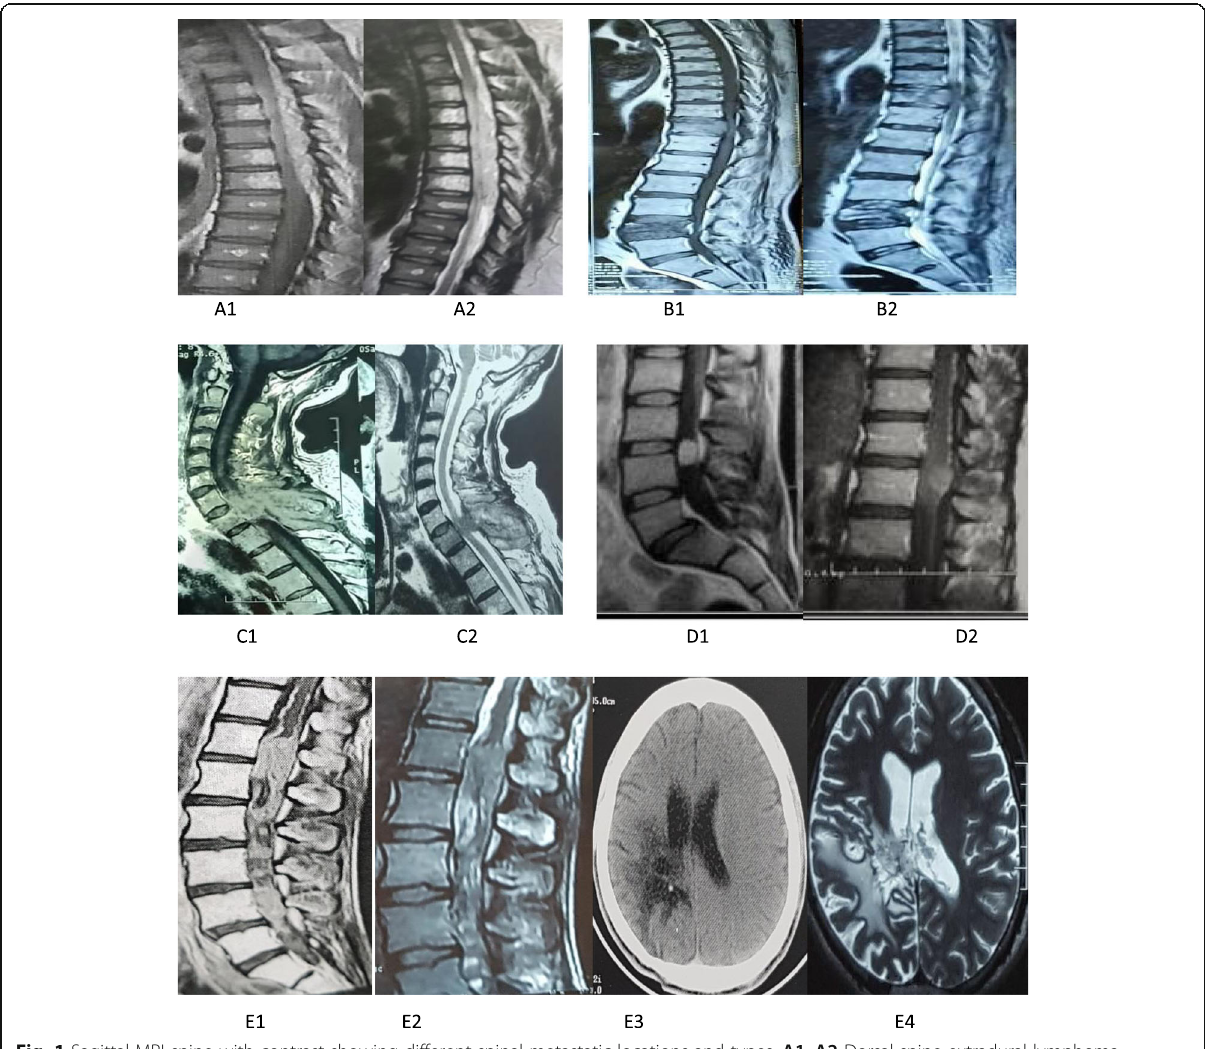
Fig. 1 Sagittal MRI spine with contrast showing different spinal metastatic locations and types. A1 , A2 Dorsal spine extradural lymphoma metastases. B1 , B2 Dorsolumber spine extradural prostatic metastases. C1 , C2 Cervical spine extradural metastatic hepatoma. D1 , D2 Dorsolumber spine intradural-extramedullary multiple myeloma of the same patient. E1 , E2 Dorsolumber spine intradural and intramedullary metastatic ependymoma. E3 , E4 CT and MRI brain of the same patient who operated 4 years before spinal metastases for brain